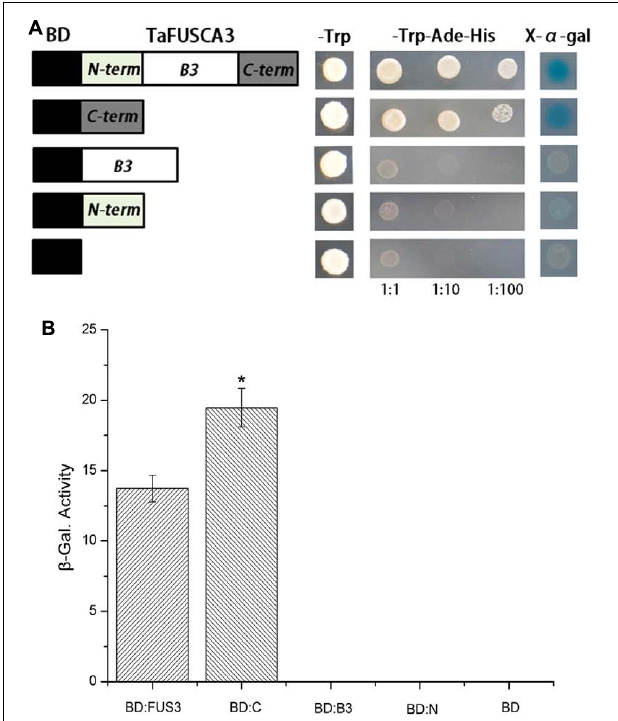
FIGURE 7 | Analysis of transcriptional activity of TaFUSCA3. (A) The growth status of yeast strains in the Y1H assay was observed on selective medium. (B) The recombinant constructs including the ORF of TaFUSCA3 and intersected fragments were transformed into the yeast strain Y187 to analyze the transcriptional activity. LacZ induction was employed to evaluate activation domains within TaFUSCA3. Data are means ± SD ( n = 3) in the Y1H system assays. Asterisks represent statistically significant differences from BD:FUS ( ∗ P < 0.05).